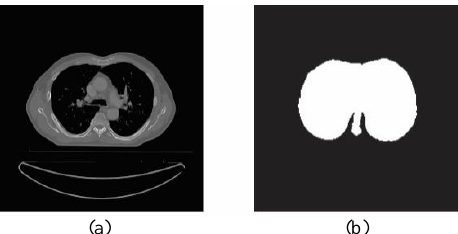
Figure 1. Preview CT scan and mask images sample: a) Sample of a CT scan image, b) The image mask of